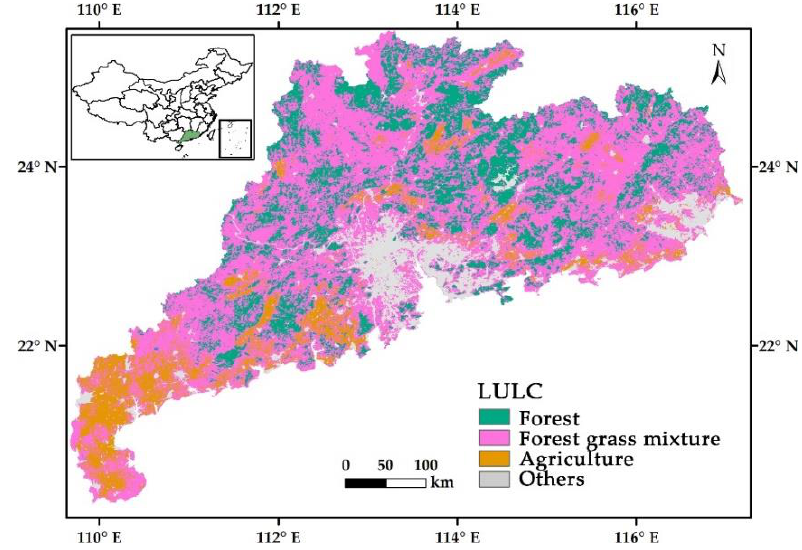
Figure 1. Land use / land cover map of study area (Guangdong Province) from the international geosphere biosphere programme (IGBP) product of Moderate Resolution Imaging Spectroradiometer (MODIS) in 2016.